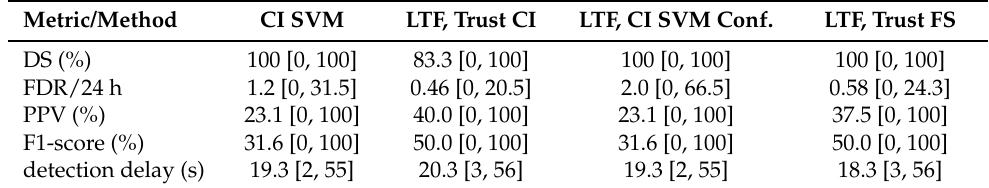
Table 2. Median [range] of performances of: CI SVM; LTF with the confidences of this SVM (CI SVM conf.); and LTF with trust models trained on CI (trust CI) and FS (trust FS) labels.